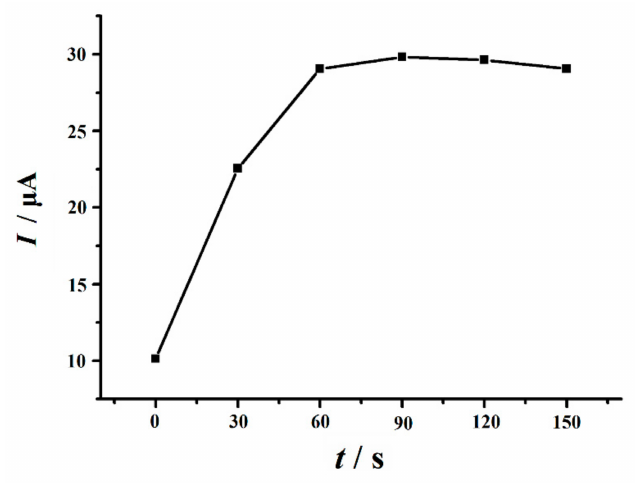
Figure 7. E ff ect of accumulation time on the peak current of 10 µ M Trp in 0.1 M PBS (pH 2.2). Accumulation potential: 0.0 V, scan rate: 0.1 V s − 1